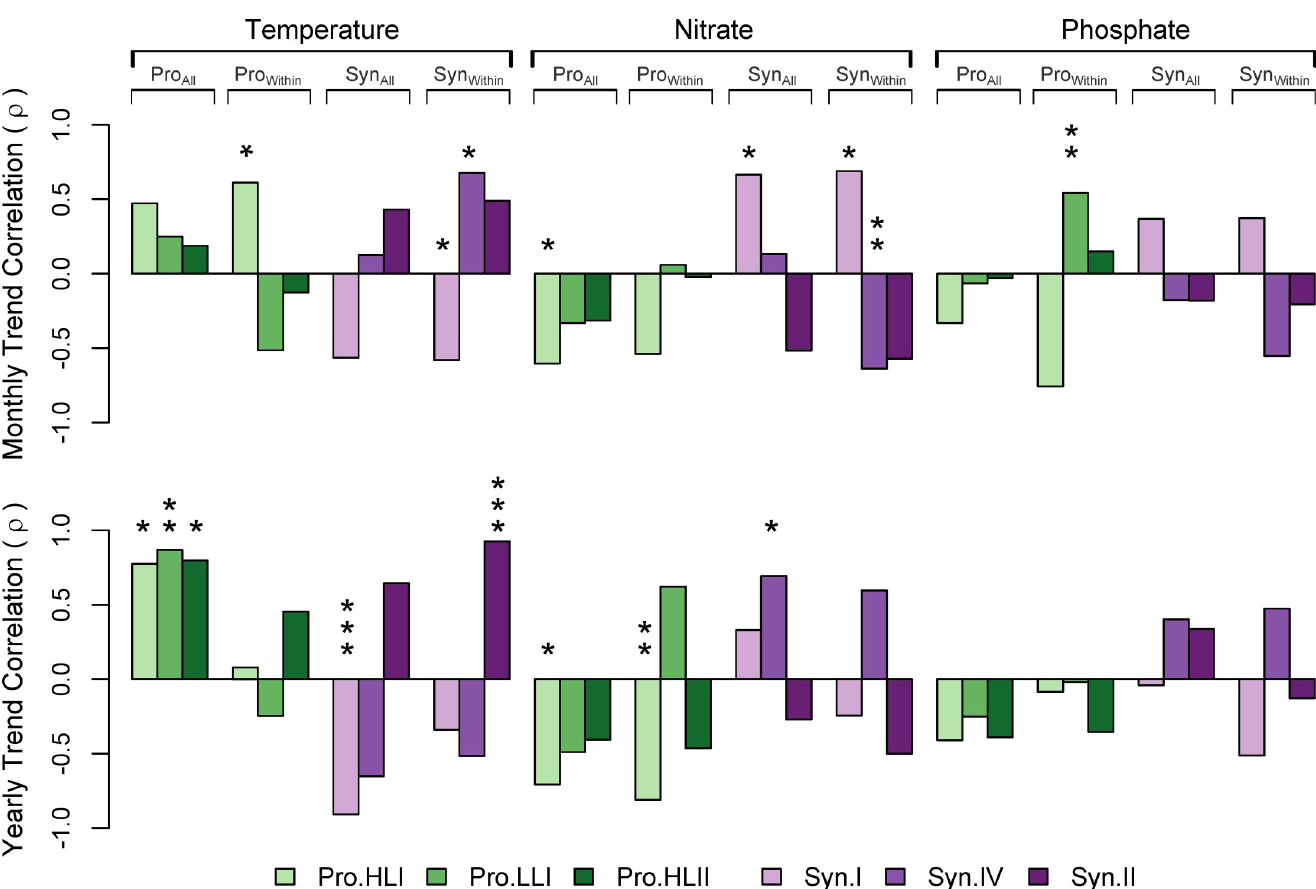
Fig 2. Pearson correlation coefficients ( r ) between relative abundance trends and environmental trends. The significance of each correlation is marked as p -value: � < 0.05, �� < 0.01, ��� < 0.001. Bars without a mark had a non-significant correlation.